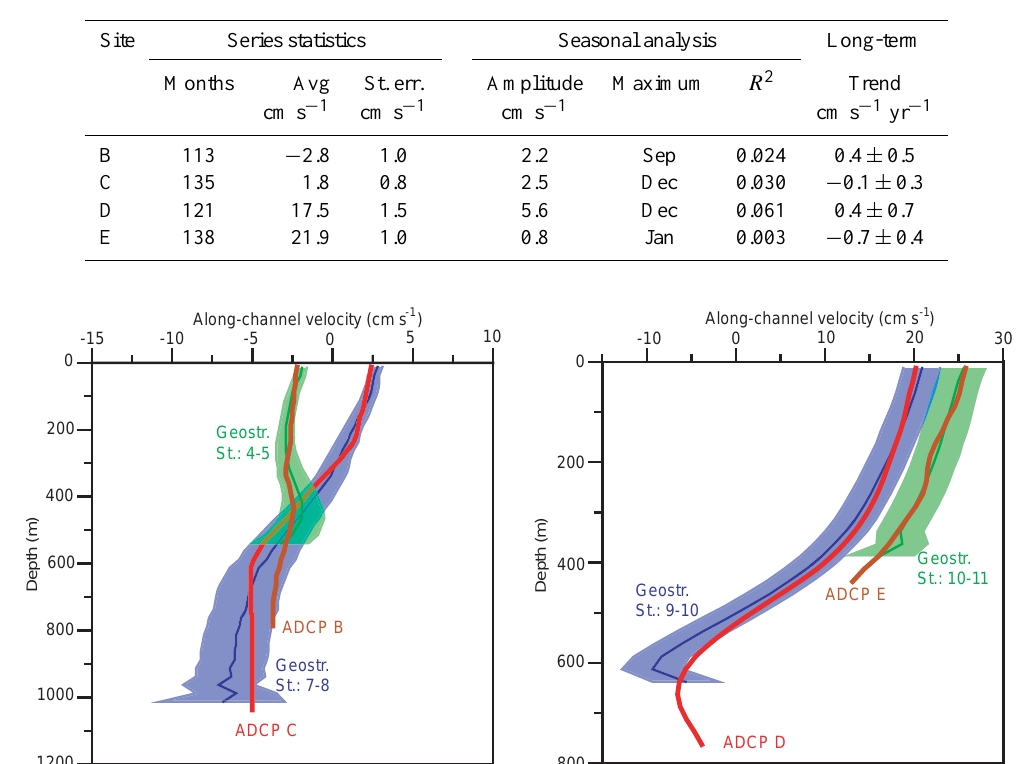
Table 3. Varibility of AW velocity (see text for definition) for the four long-term ADCP locations. The table lists the number of months, series average, and standard error. Then the results of fitting to a sinusoidal seasonal variation: amplitude, month of maximum velocity, and the R 2 value for the fit. The last column shows the long-term trend with 95% confidence limit, based on a linear regression analysis of the seasonal residuals on time.